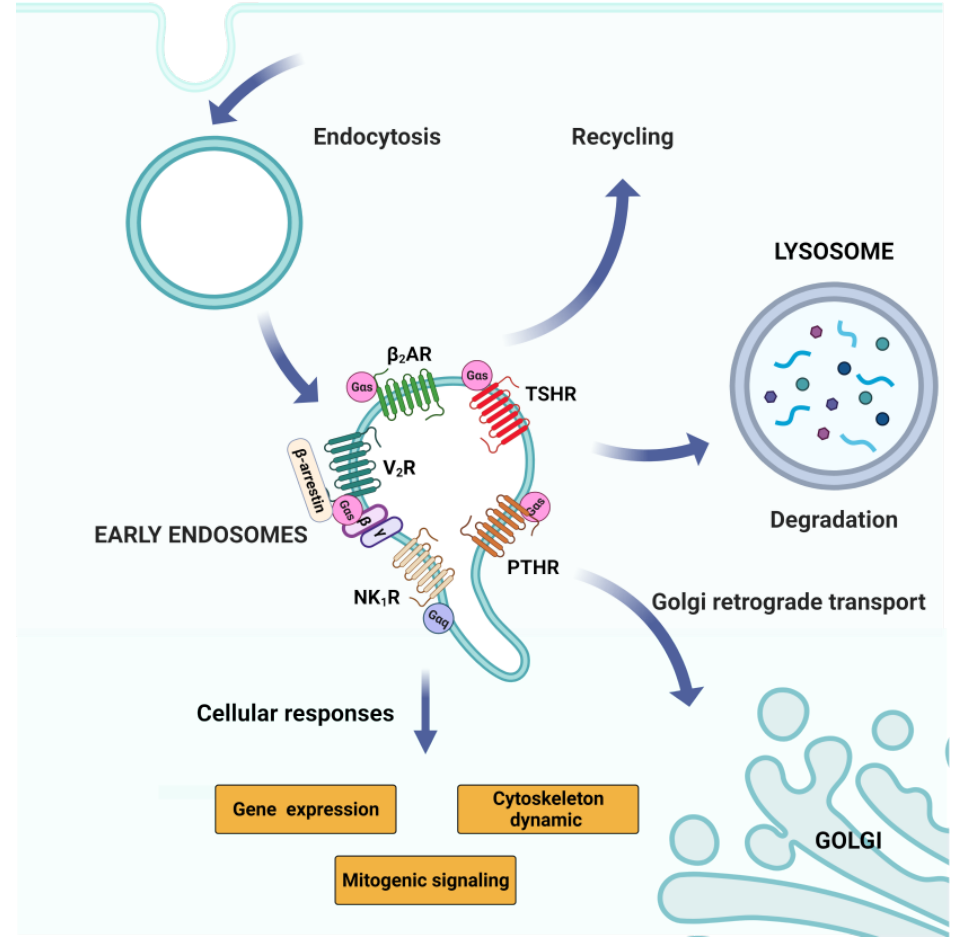
Figure 4. G-proteins and GPCR signaling in the endomembrane system: Endosomal signaling.